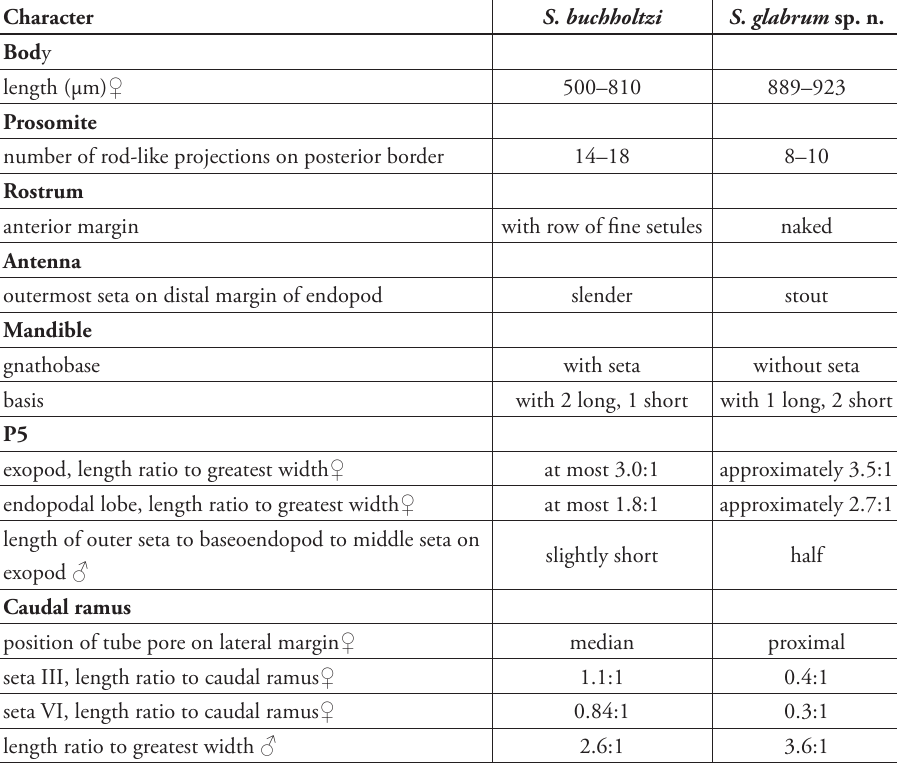
Table 1. Morphological differences between Strongylacron buchholtzi and S. glabrum sp.